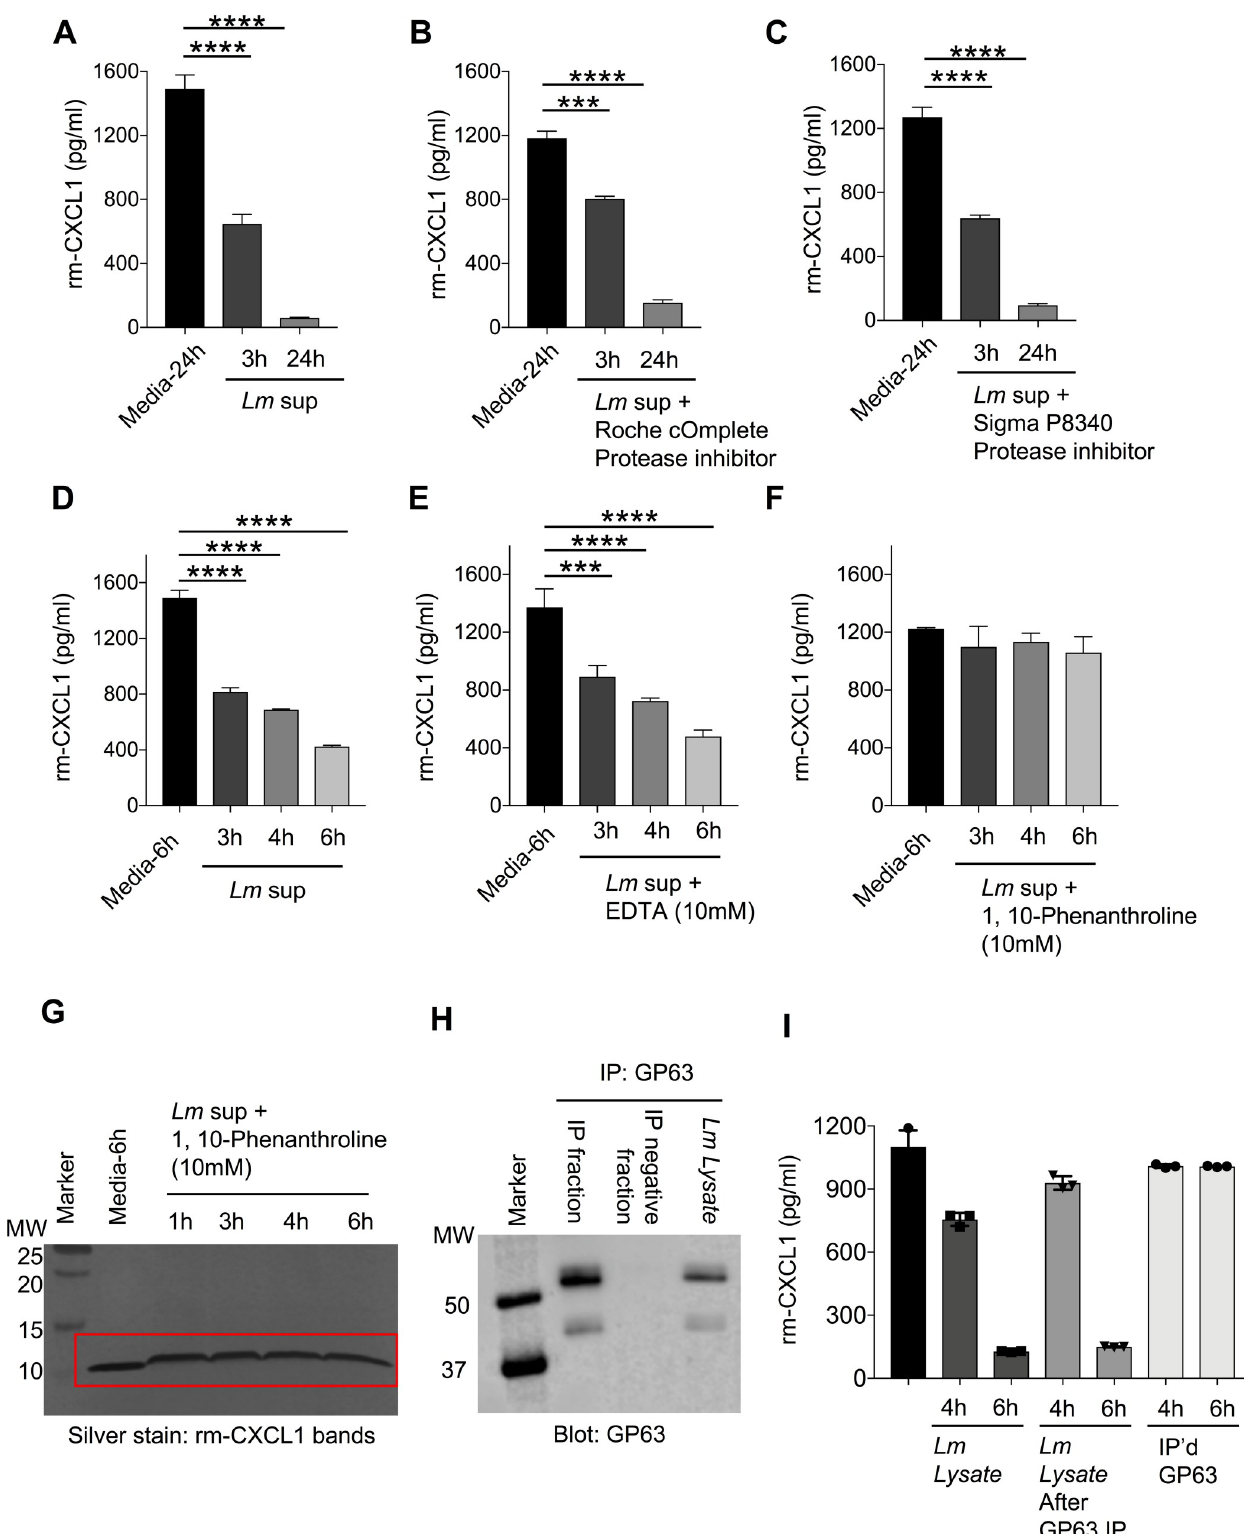
Fig 6. L . major metalloprotease cleaves CXCL1. (A) Recombinant CXCL1 was incubated with or without Lm sup containing (B) Roche cOmplete protease inhibitor, or (C) Sigma P8340 protease inhibitor for indicated time-points and subjected to CXCL1 quantification using ELISA. (D) Recombinant